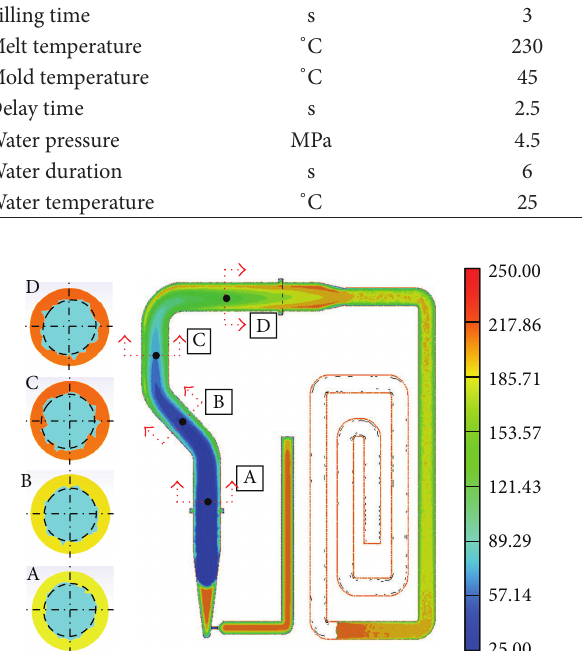
Figure 3: The hollow section and temperature distribution after water penetration in simulation analysis.